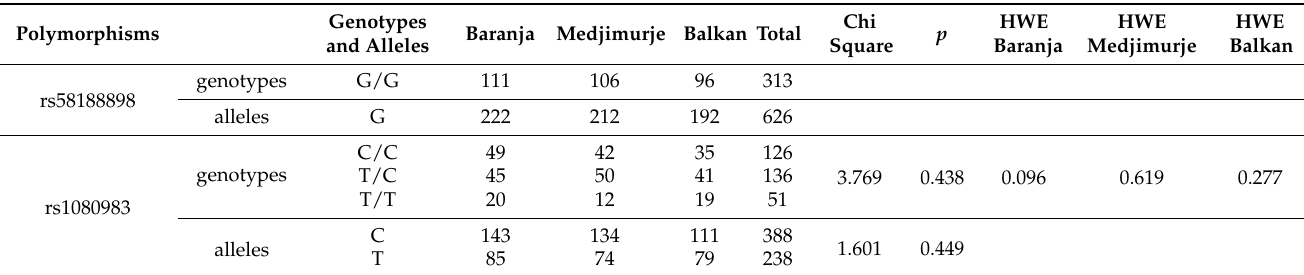
The two CYP2D6 gene enhancer SNPs are highlighted in grey, while the other SNPs are from the promoter region. Significant Chi-square and HWE p -values are shown in bold. In Table 2, the linkage disequilibrium (LD) values for the three Croatian Roma subpop- ulations (r 2 values) are shown for pairs of two enhancer (rs133333 and rs5758550) and six